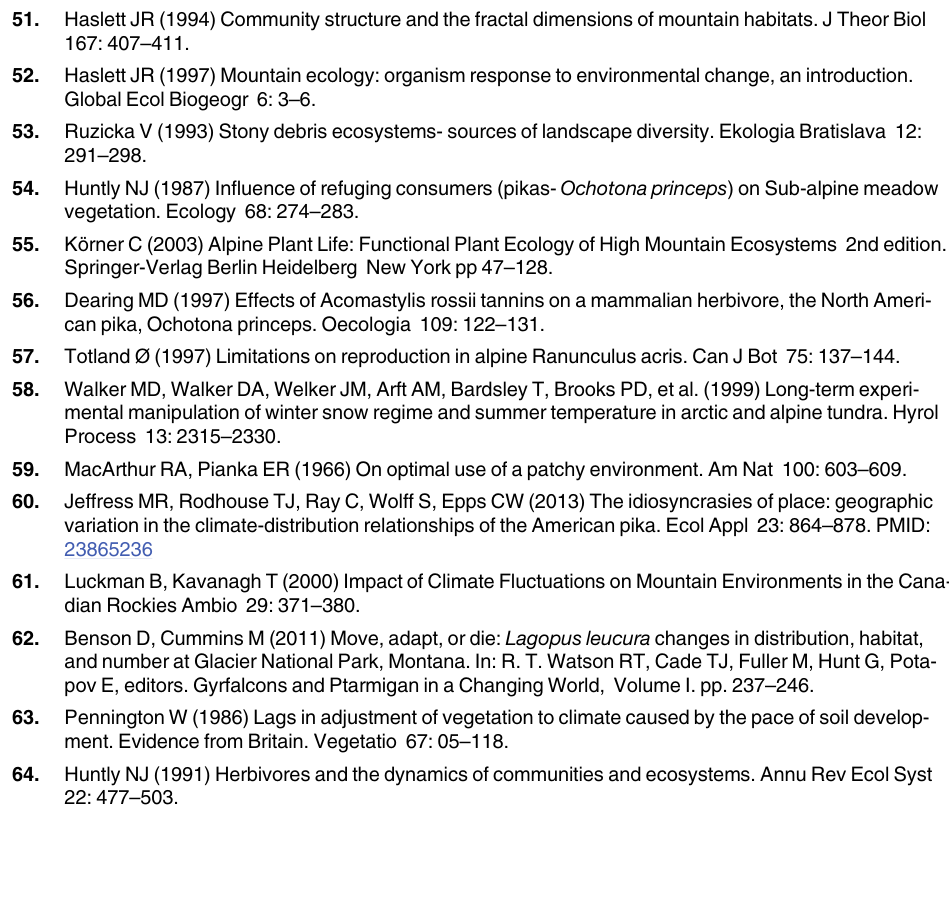
PLOS ONE | DOI:10.1371/journal.pone.0131082 August 5,